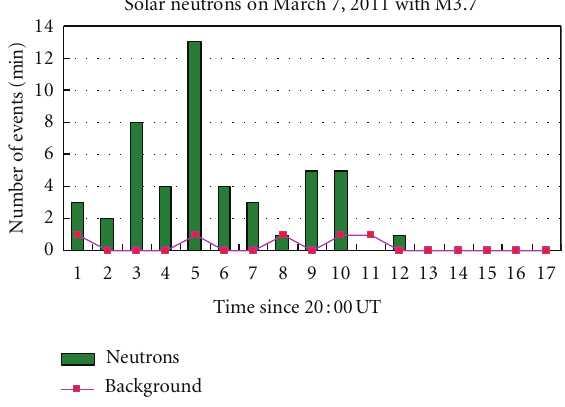
Figure 11: The arrival time distribution of neutron-induced pro- tons. The horizontal axis represents minutes after 20:00 UT. The green histogram corresponds to neutrons from the solar direction. The red curve represents the result, with equivalent analytical conditions applied to the data obtained exactly 90 minutes